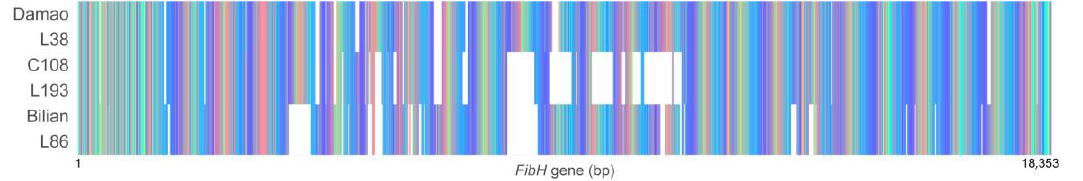
Figure 1. Comparison of the fibroin heavy chain ( FibH ) genes from pan-genome and as obtained by CACS. The FibH genes of Damao, C108, and Bilian were obtained by CACS [11], and L38, L86, and L193 were from the pan-genome.